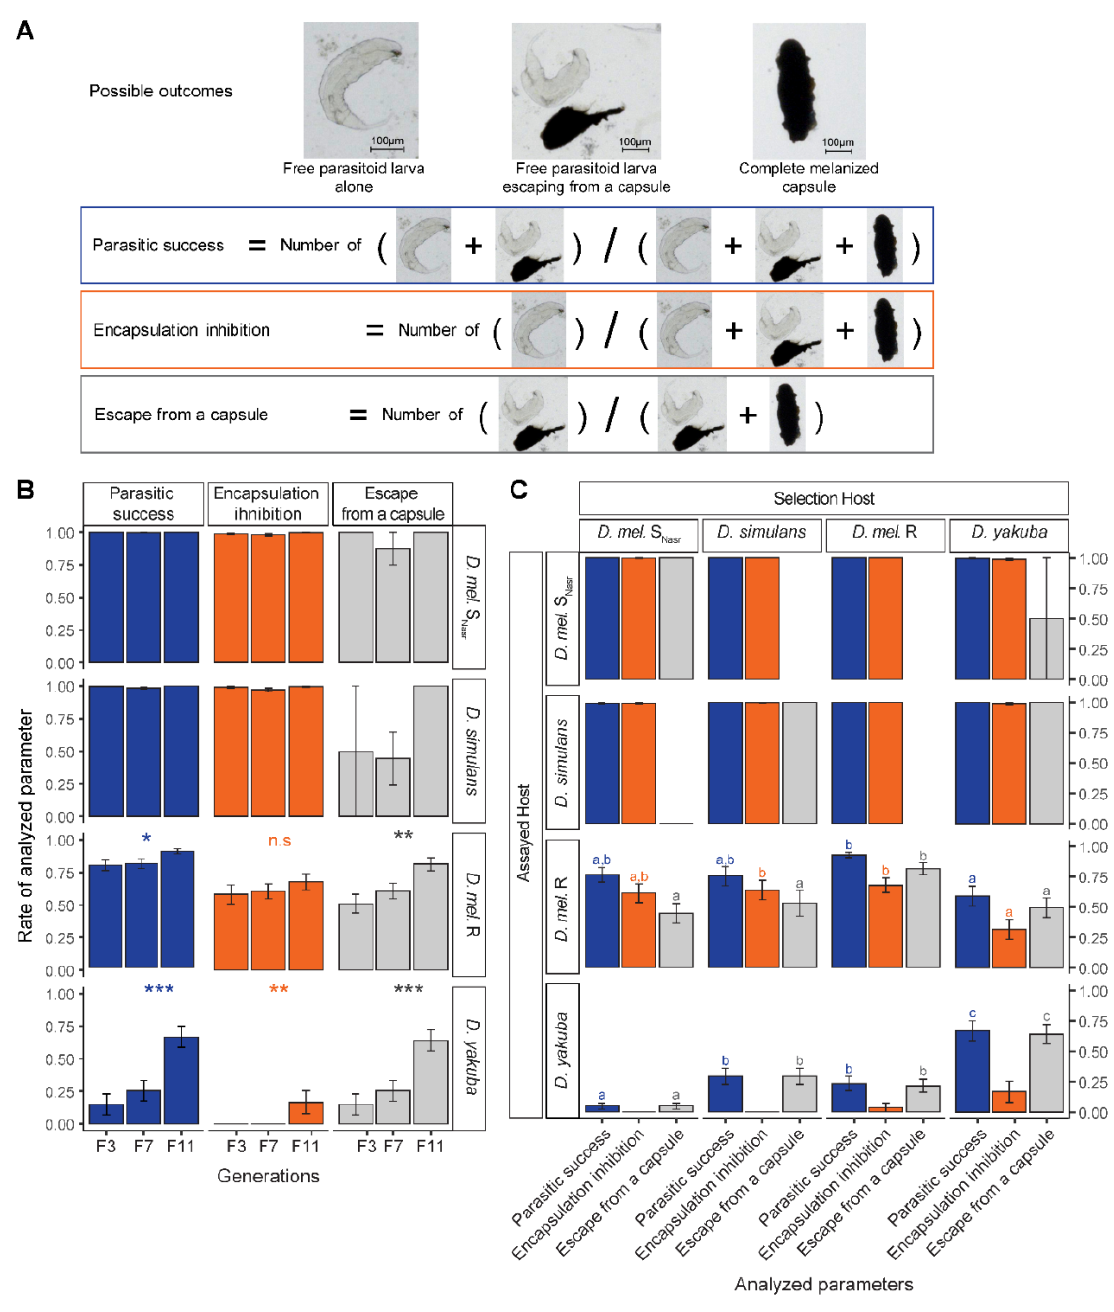
Figure 2. Evolution of the parasitoid’s ability to bypass the encapsulation response of the host. A. Possible outcomes observed in Drosophila larvae 48 hours after parasitism and details of the analyzed parameters: parasitic success, parasitoid capacity to inhibit encapsulation and parasitoid capacity to escape from a capsule. B. Evolution of (i) parasitic success, (ii) parasitoid capacity to inhibit the egg encapsulation by the host or (iii) parasitoid capacity to escape from a capsule, depending of the selection host. C. Capacity of parasitoids from the F 11 generation to bypass encapsulation by four different hosts. The hosts listed on the top are the “selection hosts”, those listed on the left are the “assayed hosts”, used for parasitism assays. D. mel .: D. melanogaster . Letters above bars indicates the significance of the difference. Different color of letters indicate different statistical tests. Error bars indicate standard